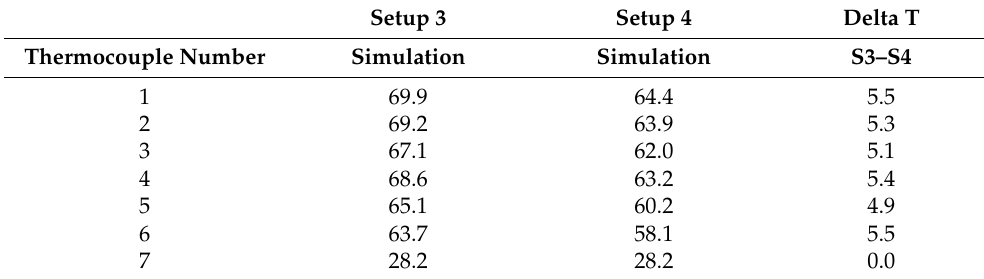
Table 11. Simulations temperature for Setup 3 and Setup 4 with adjusted temperatures for Setup 4.